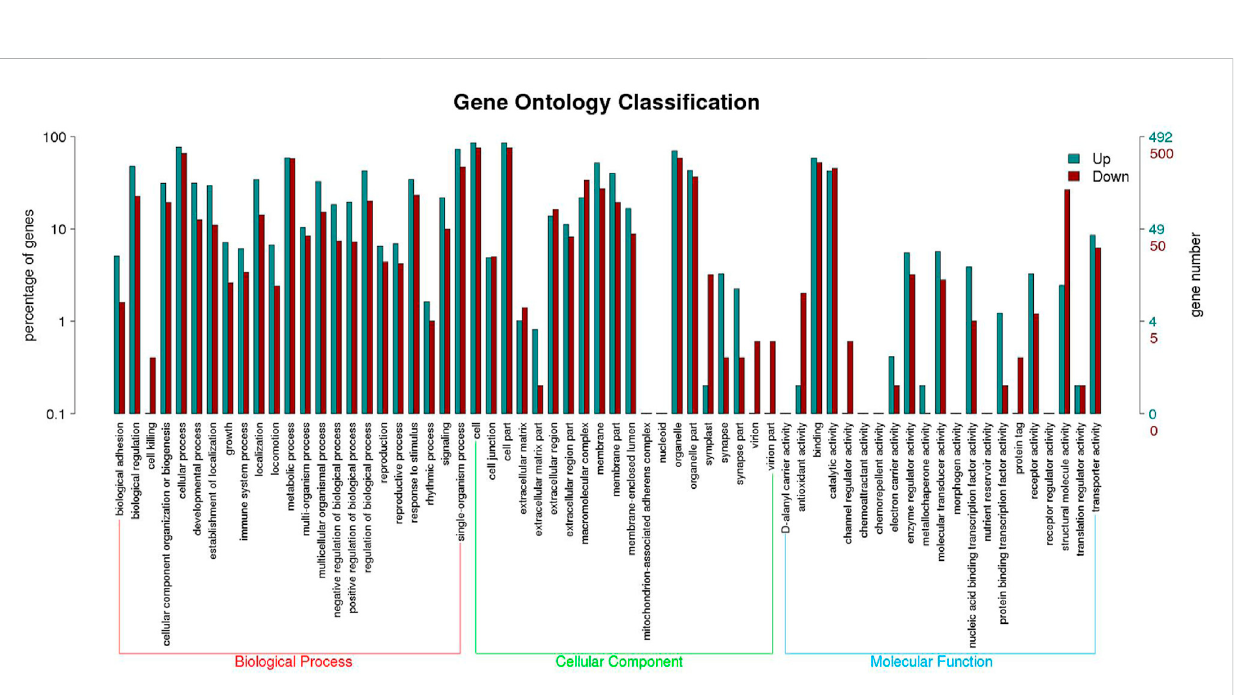
FIGURE 4 GO Level 2 classi fi cation statistics results of up- and downregulated differentially expressed genes.